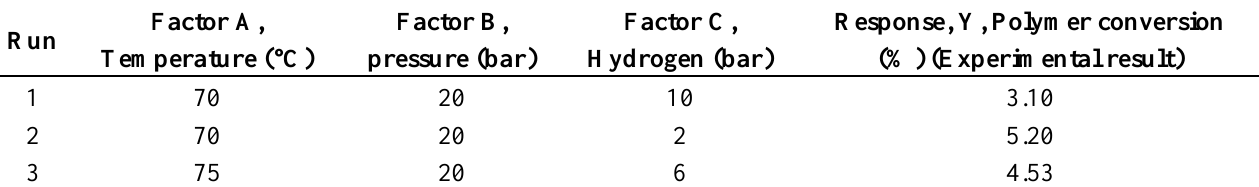
Table 2. Central Composite Design (CCD) experimental design and results of the response